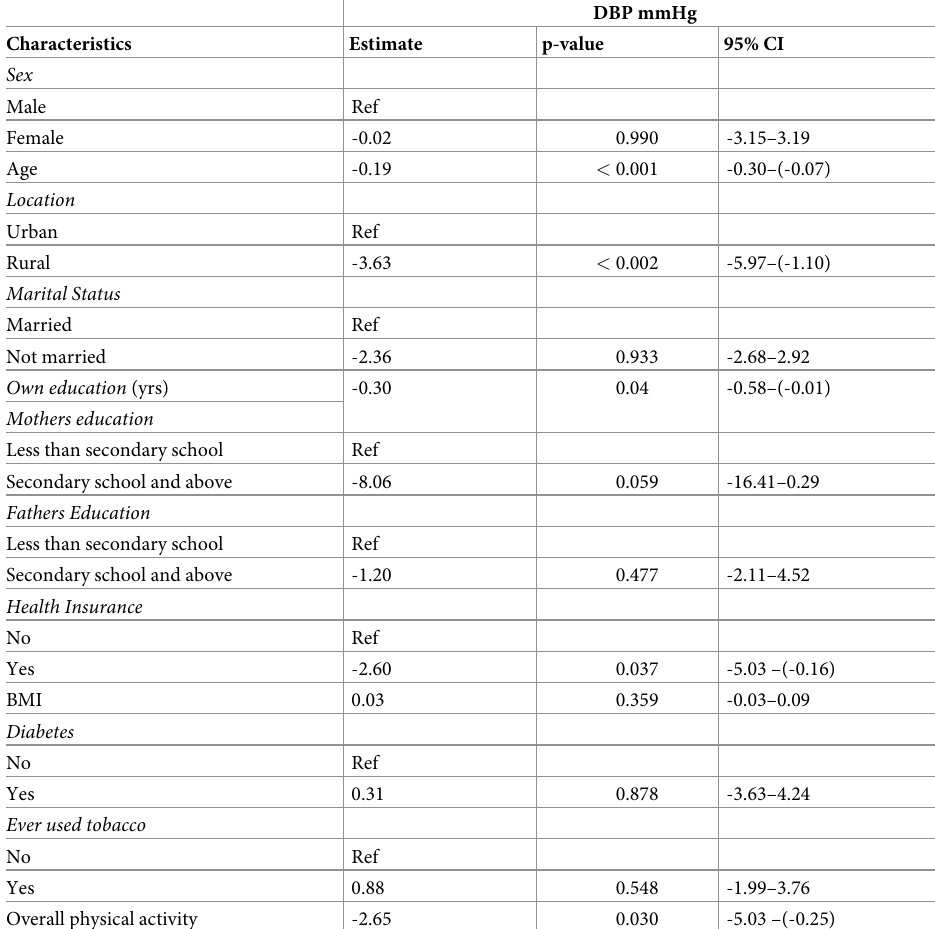
Table 2. Multivariate analysis showing the predictors of decrease in DBP (WHO-SAGE Ghana Waves 1 and 3), n = 794.